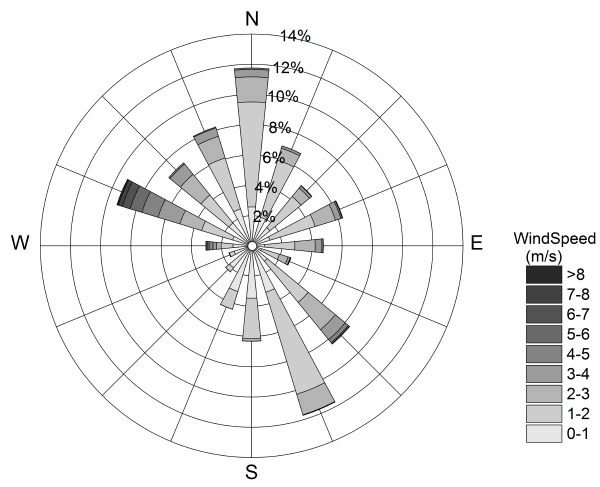
Fig. 4. The wind frequency distribution at 47m derived from all available data from 2006 to 2009. The dominant wind direction is NW and